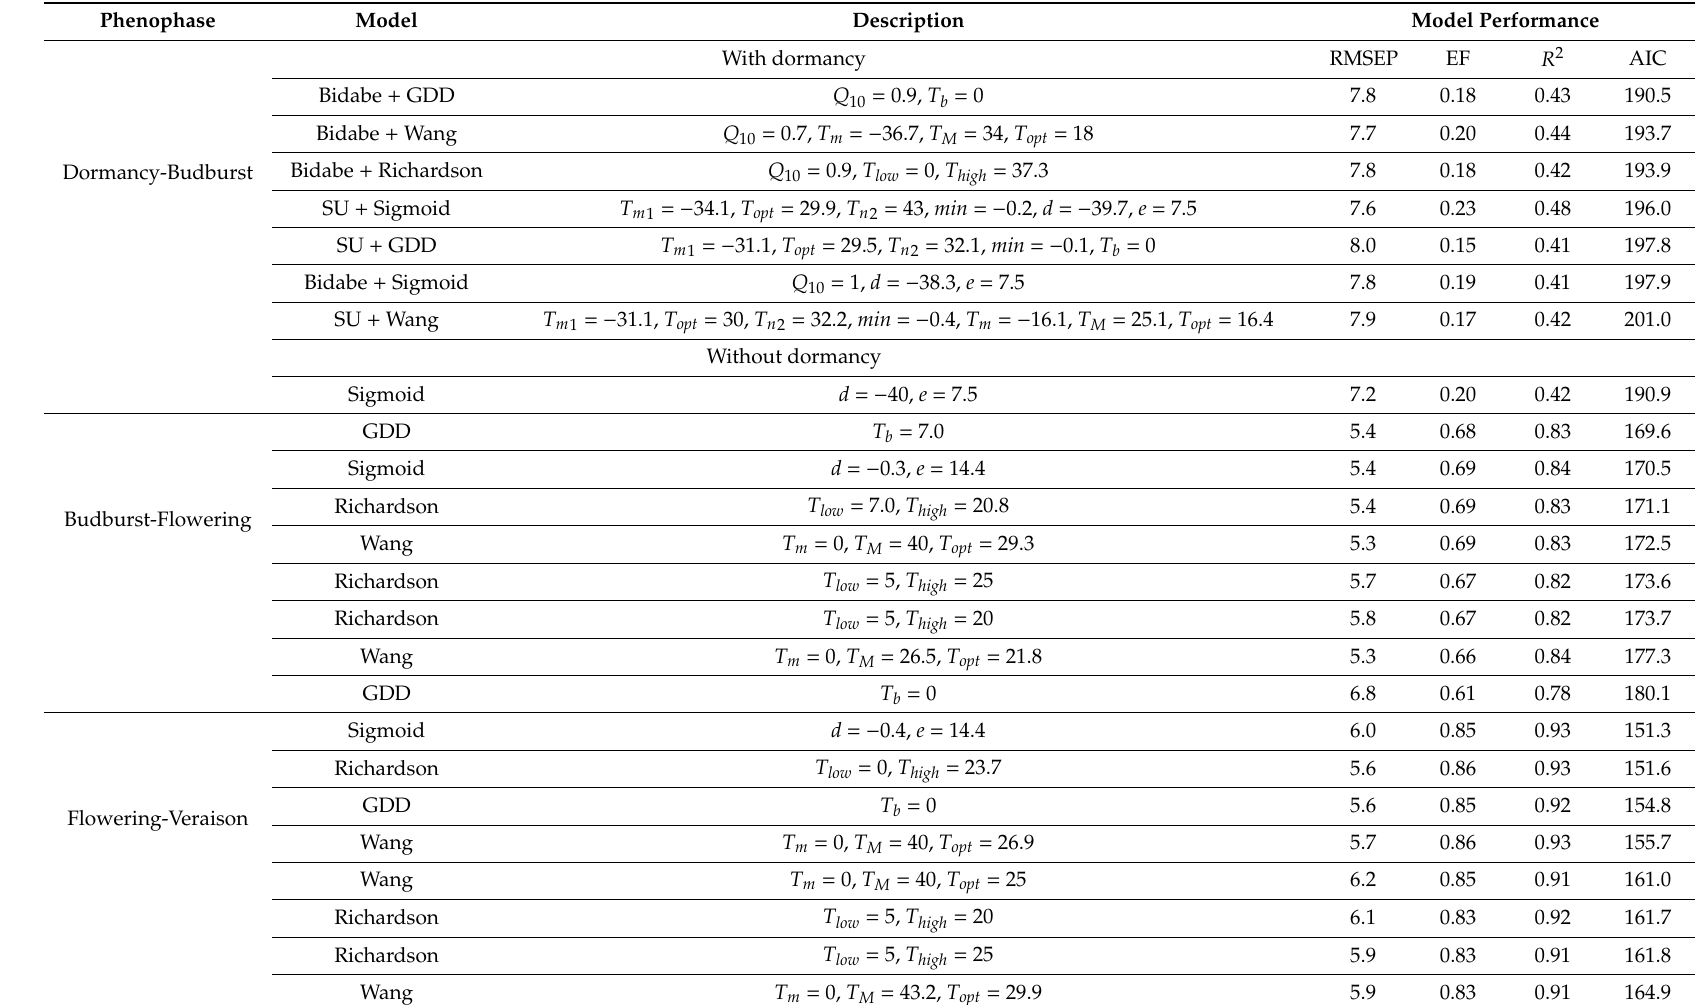
Table 6. The same as Table 5, but for cv. Touriga Nacional